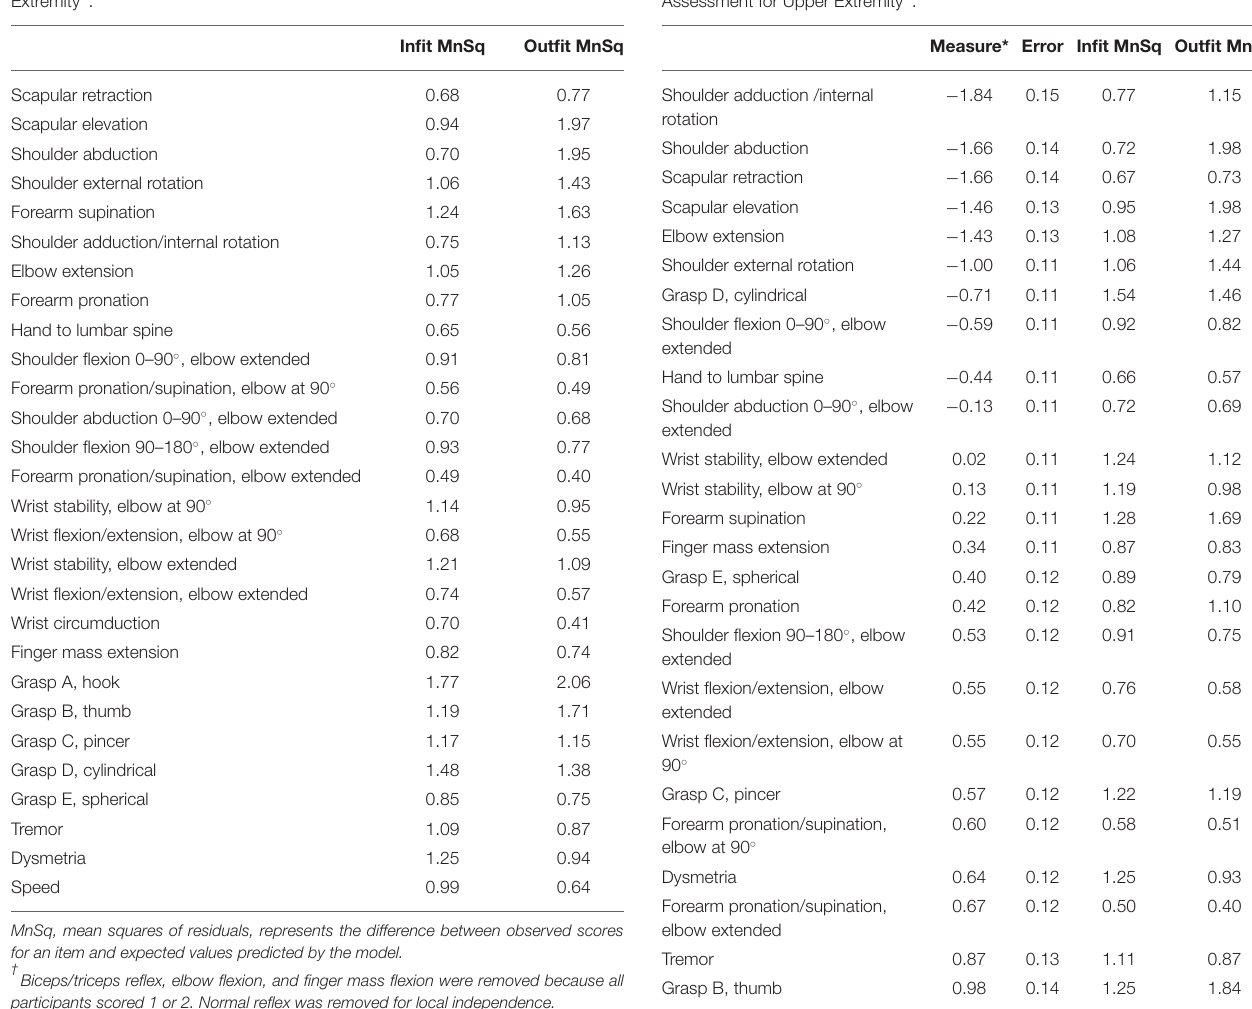
TABLE 3 | Rasch item difficulty and infit/outfit statistics of the 27-item Fugl-Meyer Assessment for Upper Extremity †